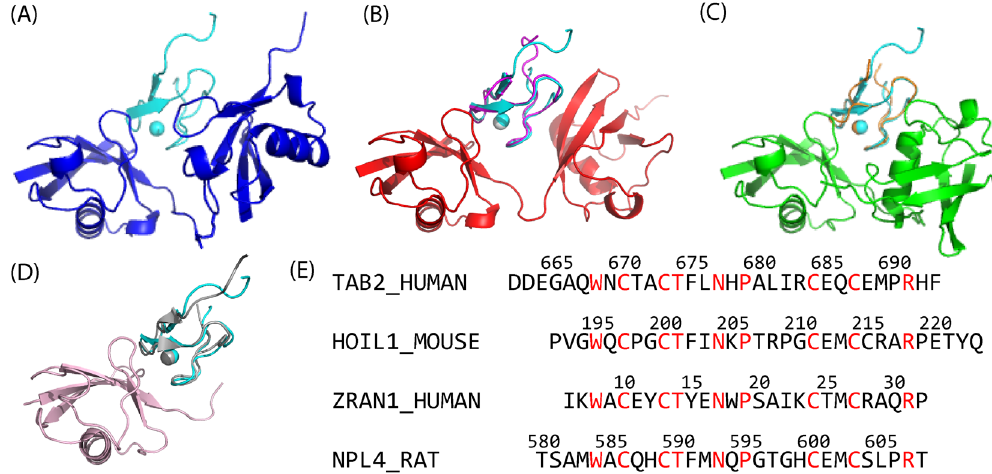
Figure 1. Crystal structures of the di-Ub/NZF complexes and sequence alignment of the NZF domains. ( A ) K63 di-Ub/TAB2 NZF (PDB: 2wwz). ( B ) Linear di-Ub/HOIL-1L NZF Δ tail (PDB: 3b0a). Here, Δ tail indicates that the NZF domain does not contain the C-terminal helix of HOIL-1L (224–249). ( C ) K33 di-Ub/ TRABID NZF1 (PDB: 5af6). ( D ) Mono Ub/NPL4 NZF (PDB: 1q5w). In ( B – D ), TAB2 NZF (cyan) is drawn after superimposition to the core region (1–70) of the distal Ub (left moiety of di-Ub) or mono-Ub. ( E ) The sequences of the NZF domains used in this study were aligned. ZRAN1 corresponds to TRABID. Red characters indicate the amino acids which are conserved in all four